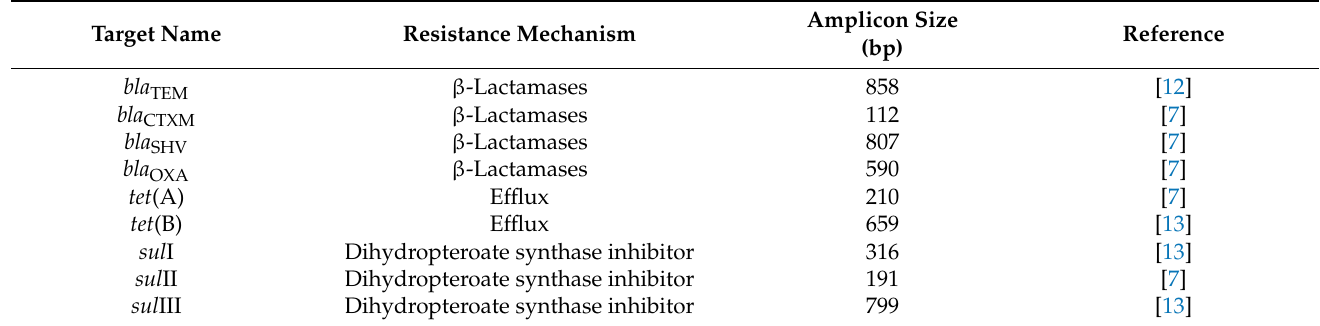
Table 1. Primers used in this